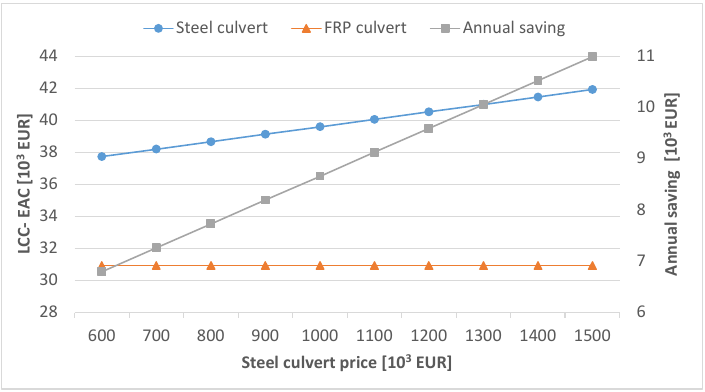
Figure 16. Impact of the steel culvert structure price on the LCC and annual saving.